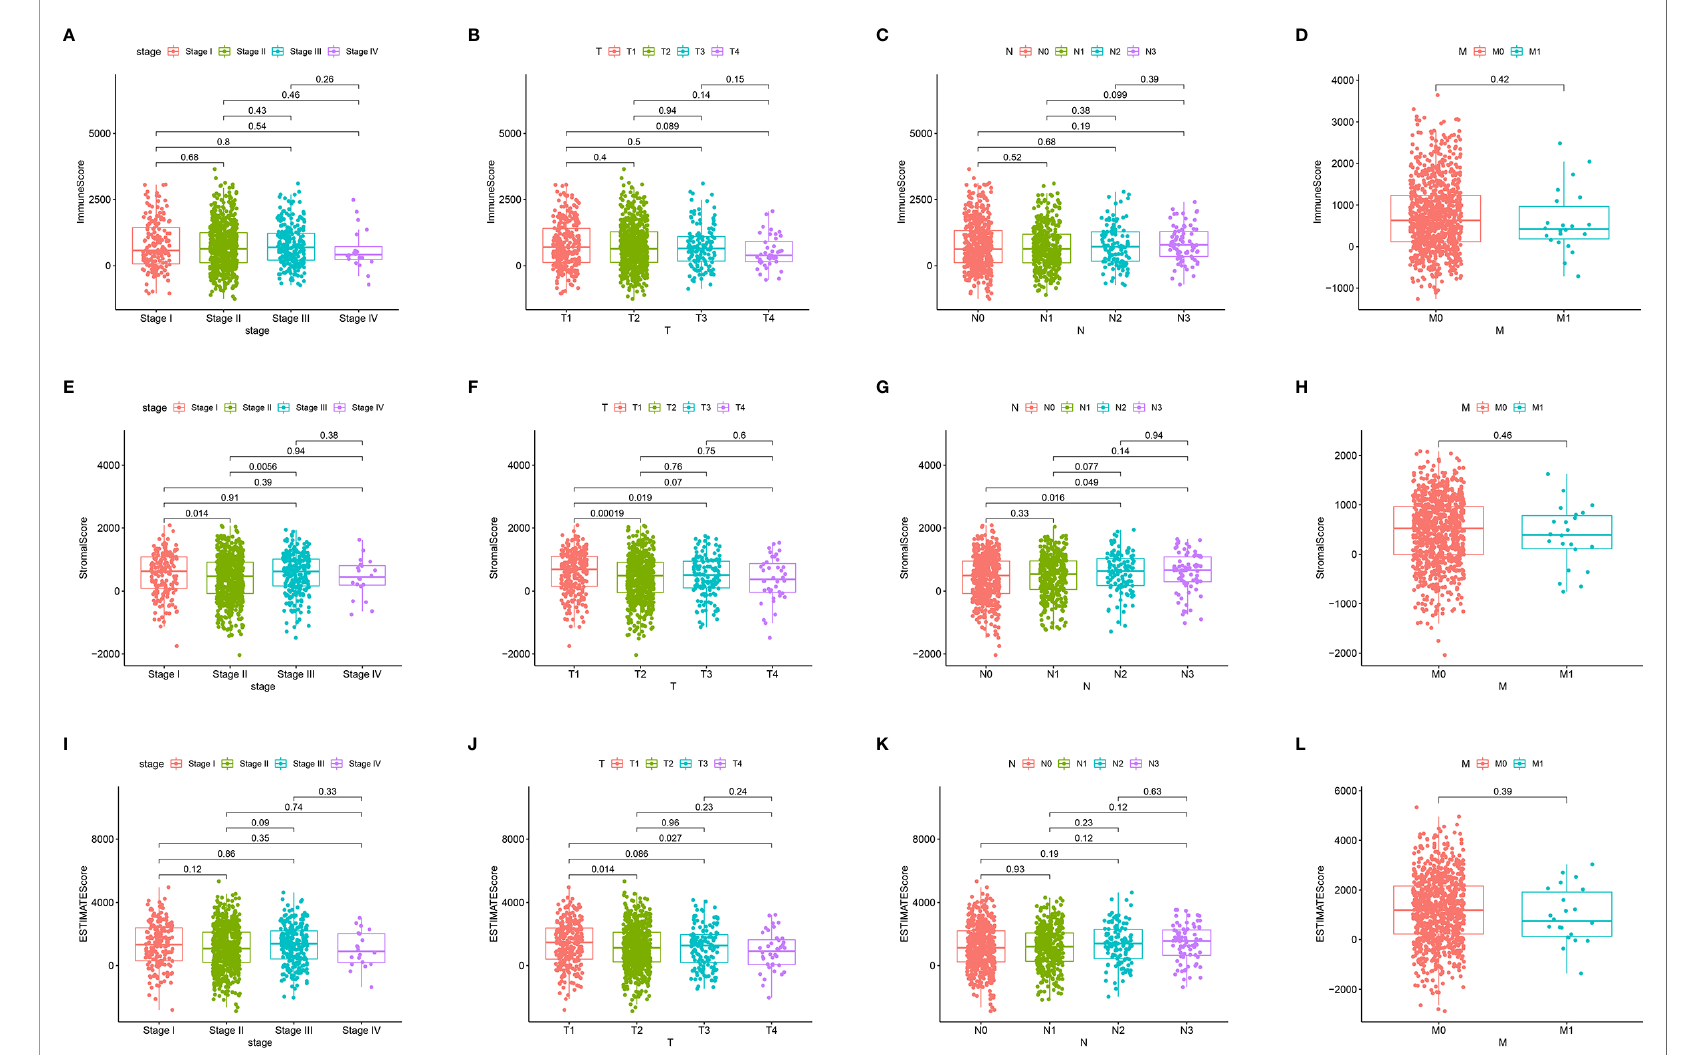
FIGURE 3 | Associations of ImmuneScore, StromalScore, and ESTIMATEScore with TNM staging. Kruskal – Wallis rank sum tests of the associations of (A – D) TME immune components, (E – H) TME stromal components, and (I – L) TME immune and stromal components with TNM